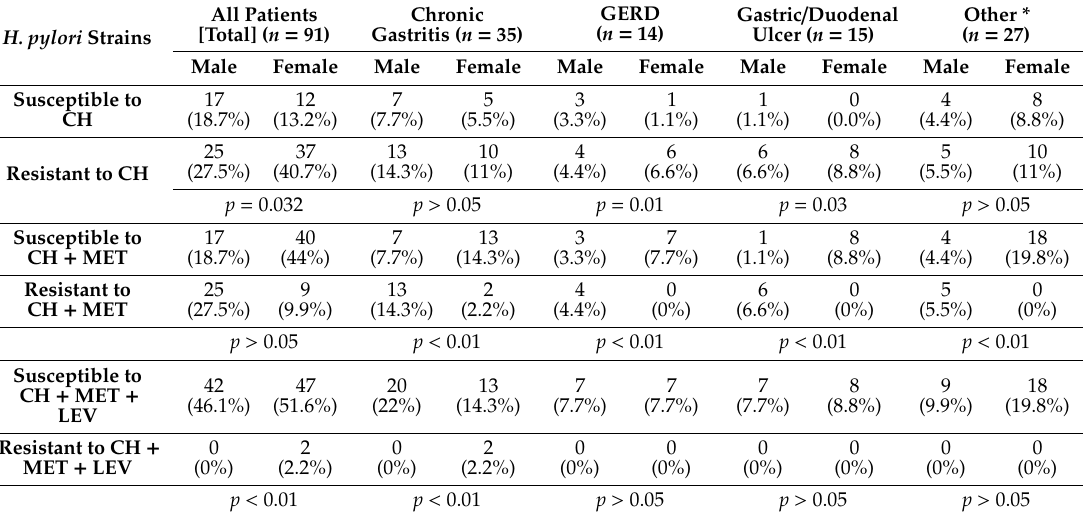
Table 1. Characteristics of the examined group of children and drug sensitivity of H. pylori